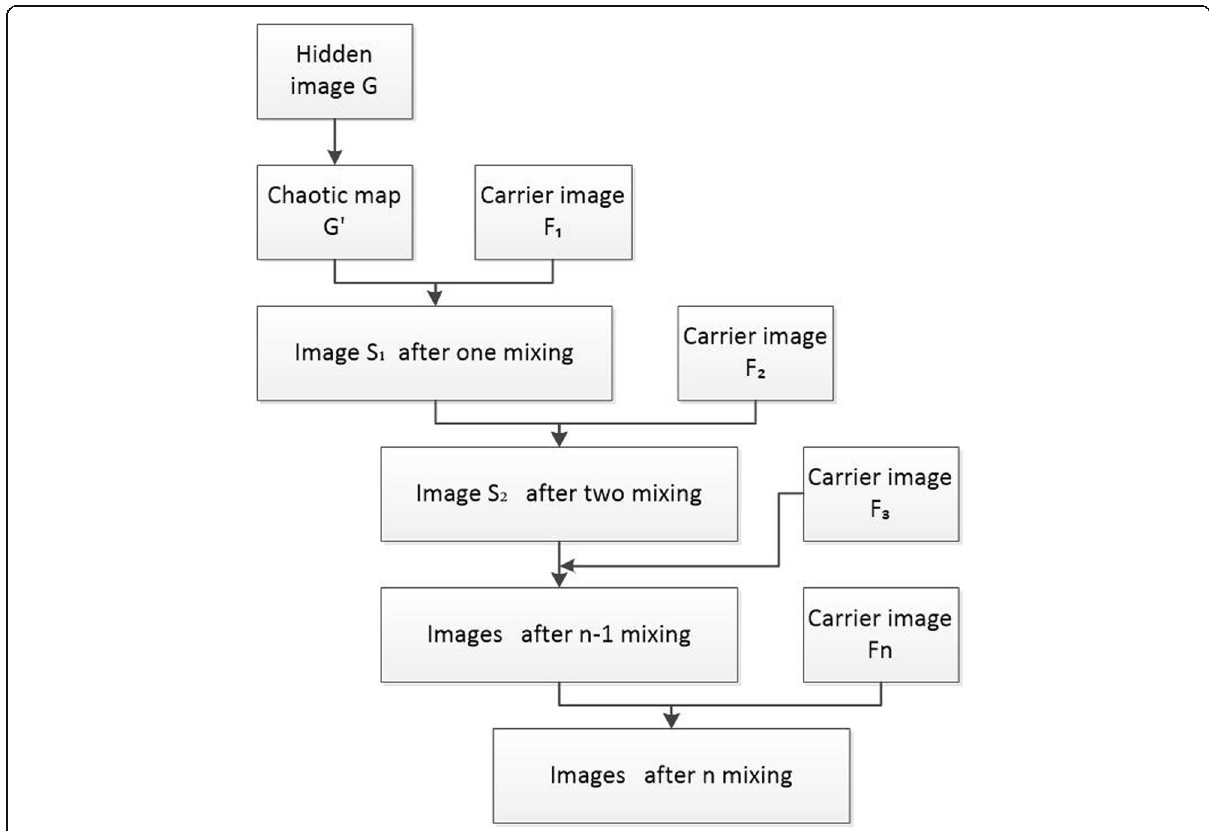
Fig. 1 Image encryption and its embedded